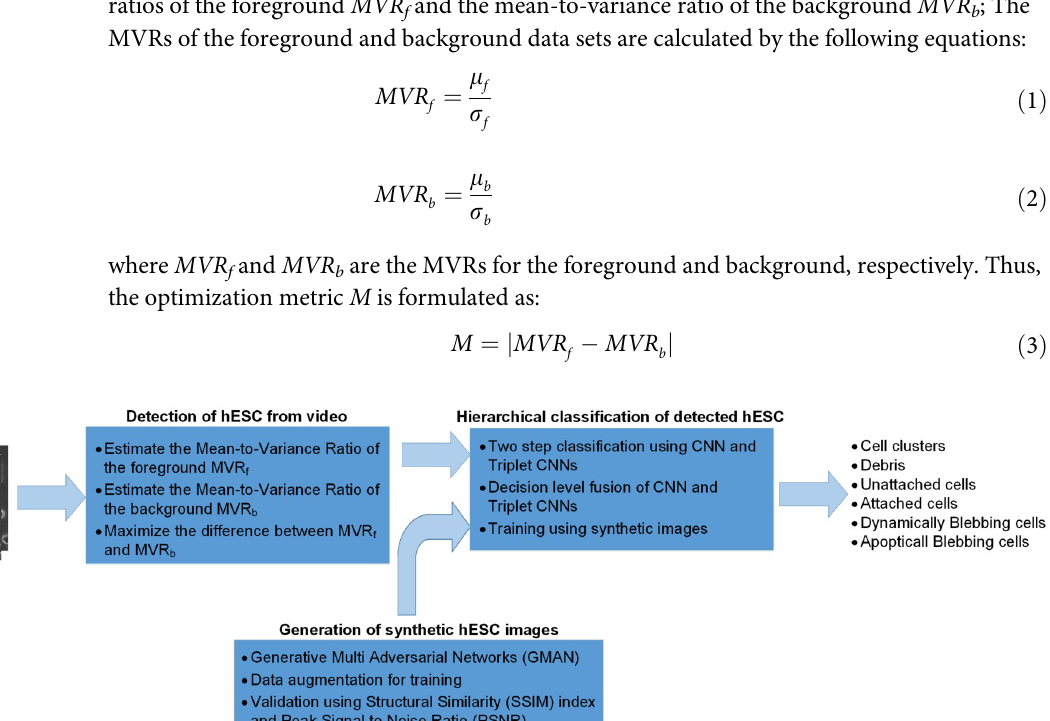
PLOS ONE | https://doi.org/10.1371/journal.pone.0212849 March 6,